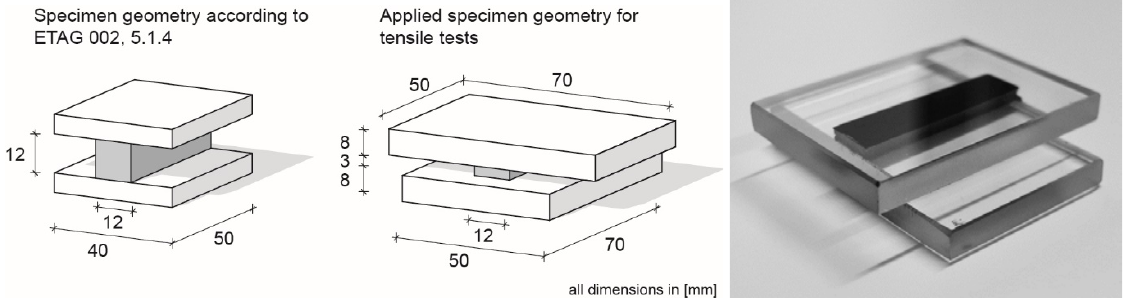
Figure 3: Specimens for tests according to ETAG 002 and EN ISO